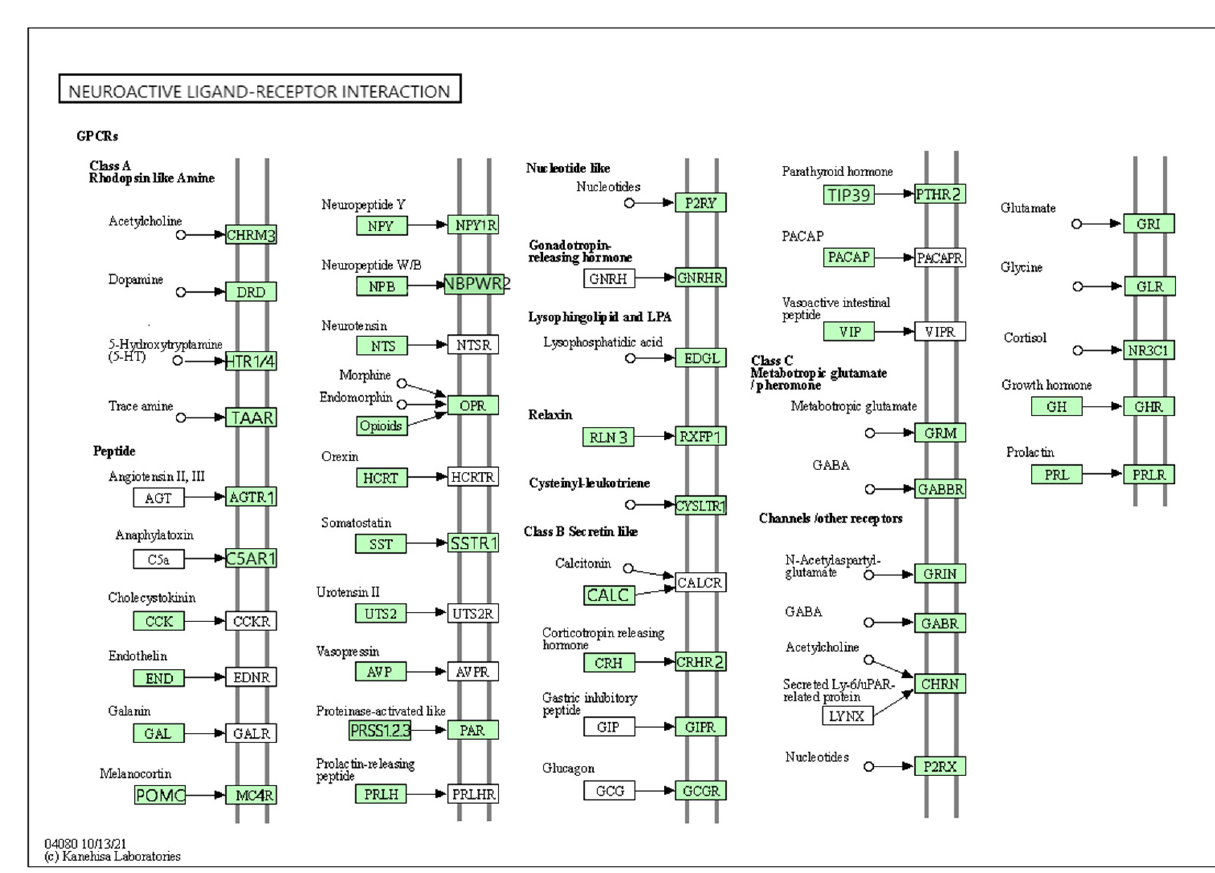
grey, pink, cyan, lightcyan, yellow, turquoise, black, and midlightblue) (R > 0.6 or R < − 0.6, p < 0.05) (Figure 7).